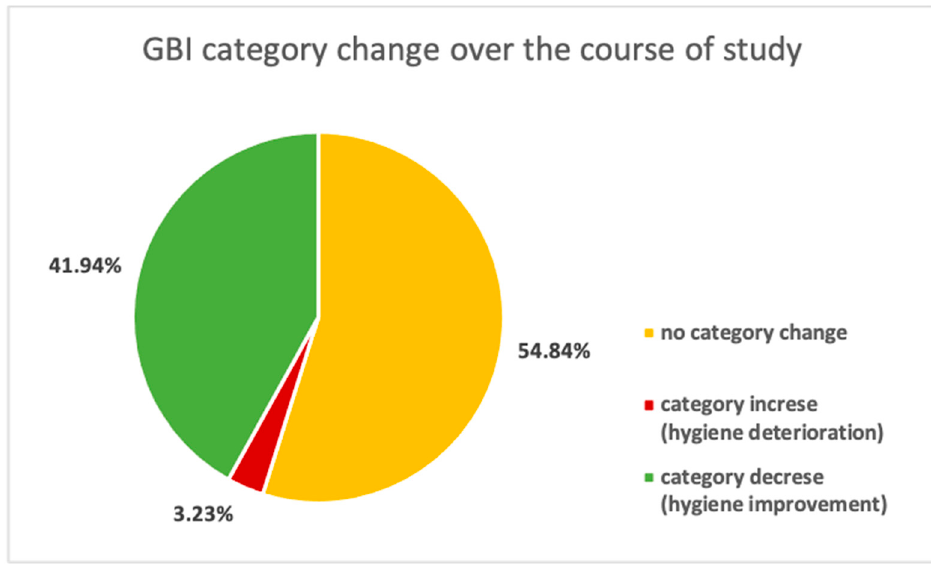
Figure 11. Participants’ potential GBI category change over the course of study.